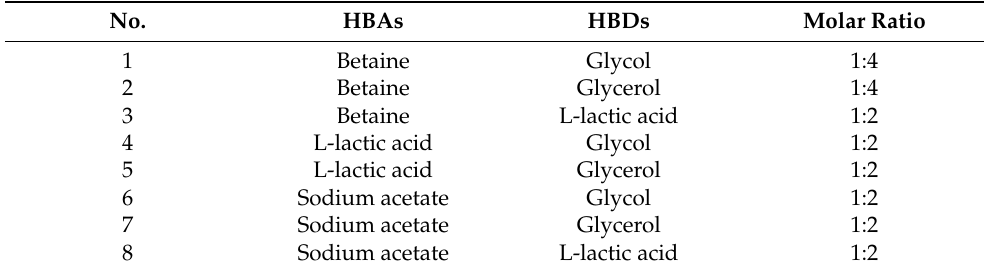
Table 1. List of DES used to extract phenolics of foxtail millet husk.